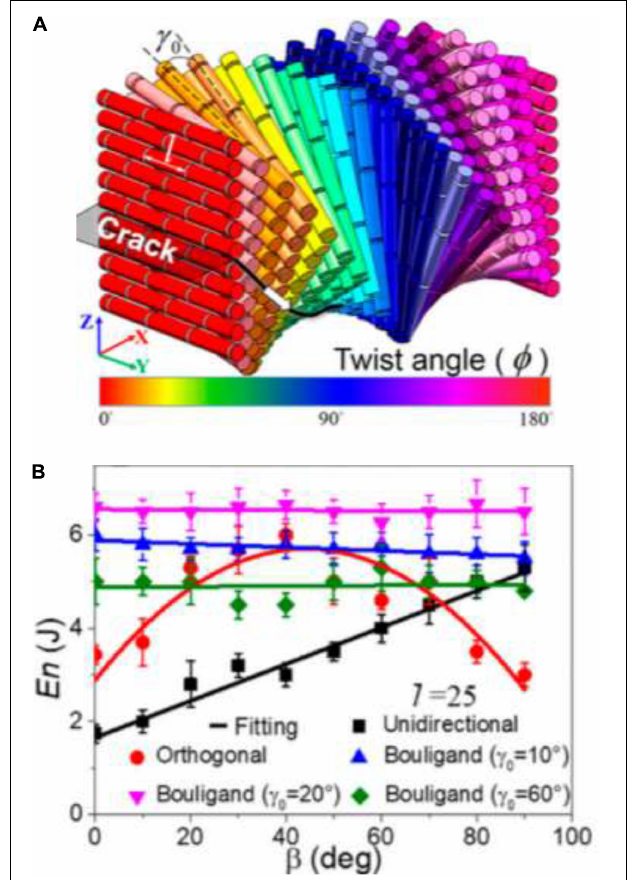
FIGURE 15 | (A) Discontinuous Bouligand fibers and (B) the numerical result of energy absorption (Wu et al.,